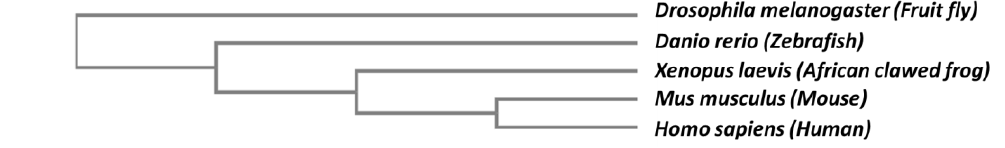
Figure 3. The phylogenetic relationship among the five selected KLF6 orthologs from D. melanogaster , D. rerio , X. laevis , M. musculus and H. sapiens . The phylogram was generated using the Clustal Omega tool (https://www.ebi.ac.uk/Tools/msa/clustalo/).